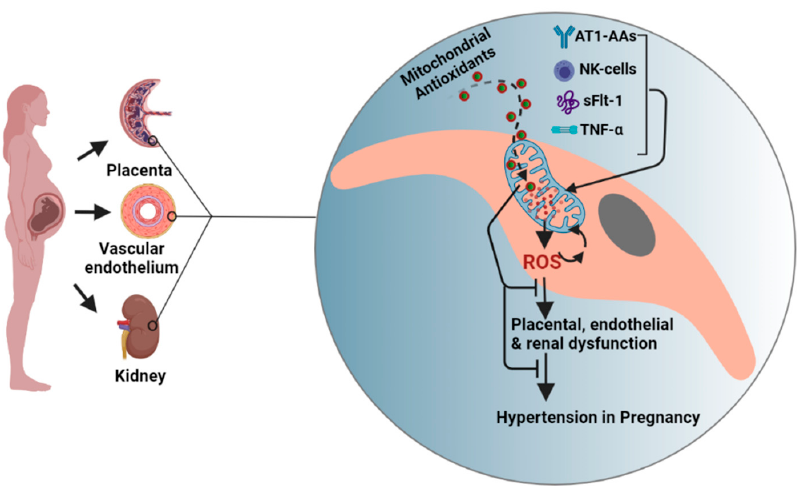
Figure 2. Conceptual figure showing organ systems and the mechanisms and the events leading to hypertension in preeclampsia. We here show a hypothetical cell from placenta orvascular endothelium orkidney to indicate mtROS mechanisms and targeted antioxidants strategy. We show TNF- α , sFlt1, AT1-AAs, and activated NK cells are some of the important pathological factors driving mitochondrial ROS in preeclampsia. Mitochondrial antioxidants MitoQ and MitoTempo accumulate in the cytoplasm (10-fold) and mitochondrial matrix (100–500-fold) based on membrane potential leading to abrogation of mitochondrial oxidative stress and organ dysfunction and hypertension. TNF- α , tumor necrosis factor; AT1-AA, agonistic antibodies to the angiotensin II receptor type 1; NK cell, natural killer cell; ROS, reactive oxygen species; sFlt1, soluble fms-like tyrosine kinase-1. The figure was created using